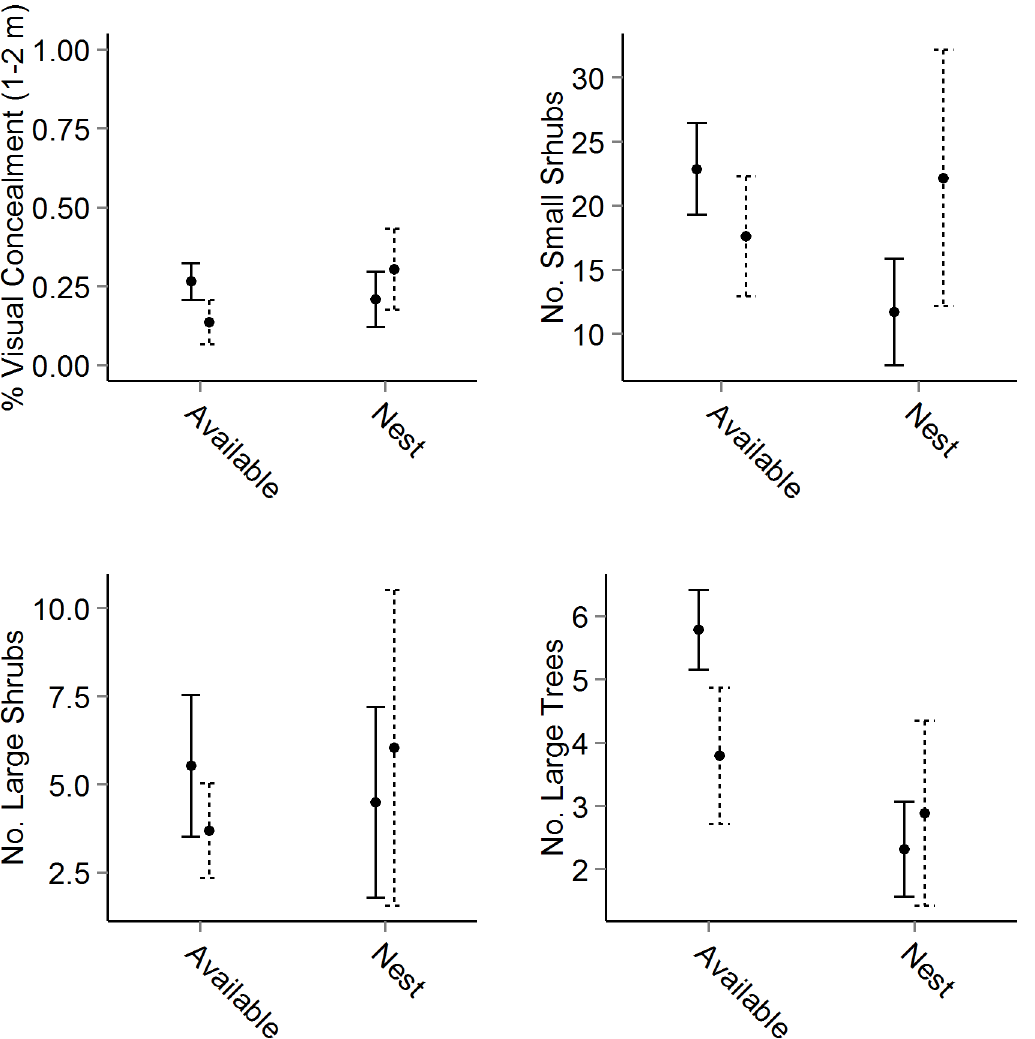
Fig 3. Mean ( ± 95% CI) for habitat variables collected at nest-sites and available sites in units treated with short-rotation prescribed fire (solid lines) and units not treated (dashed) at the White Rock Ecosystem Restoration Area, U.S. Forest Service Boston Mountain Ranger District of the Ozark National Forest, Arkansas,